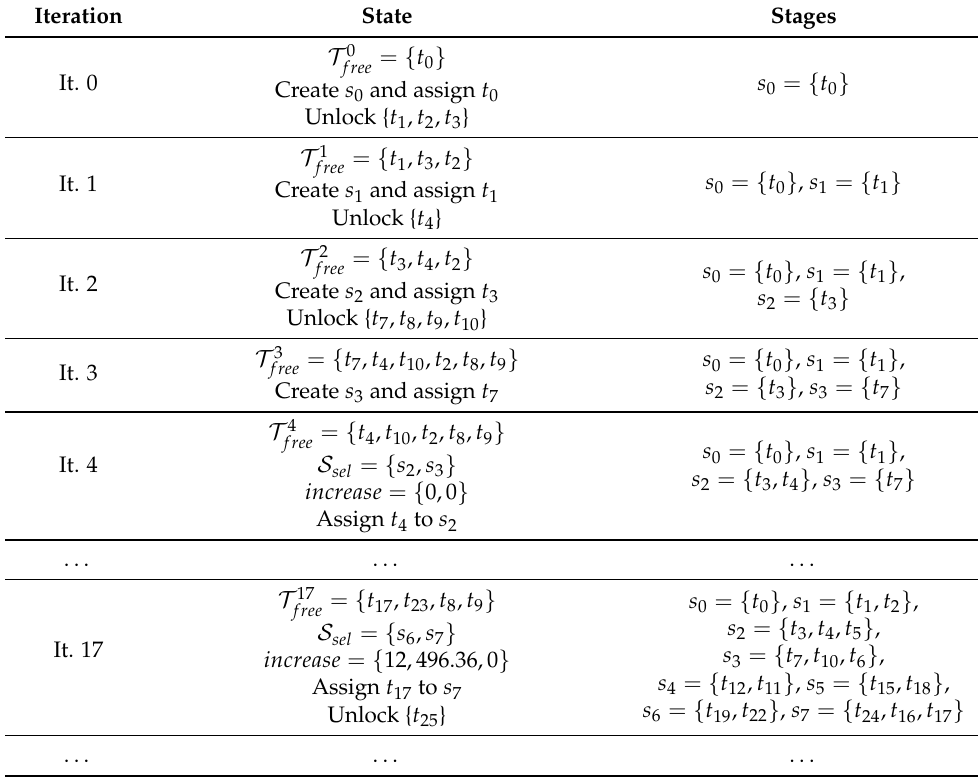
Table 8. Example of execution of Algorithm 1 at the iteration level.